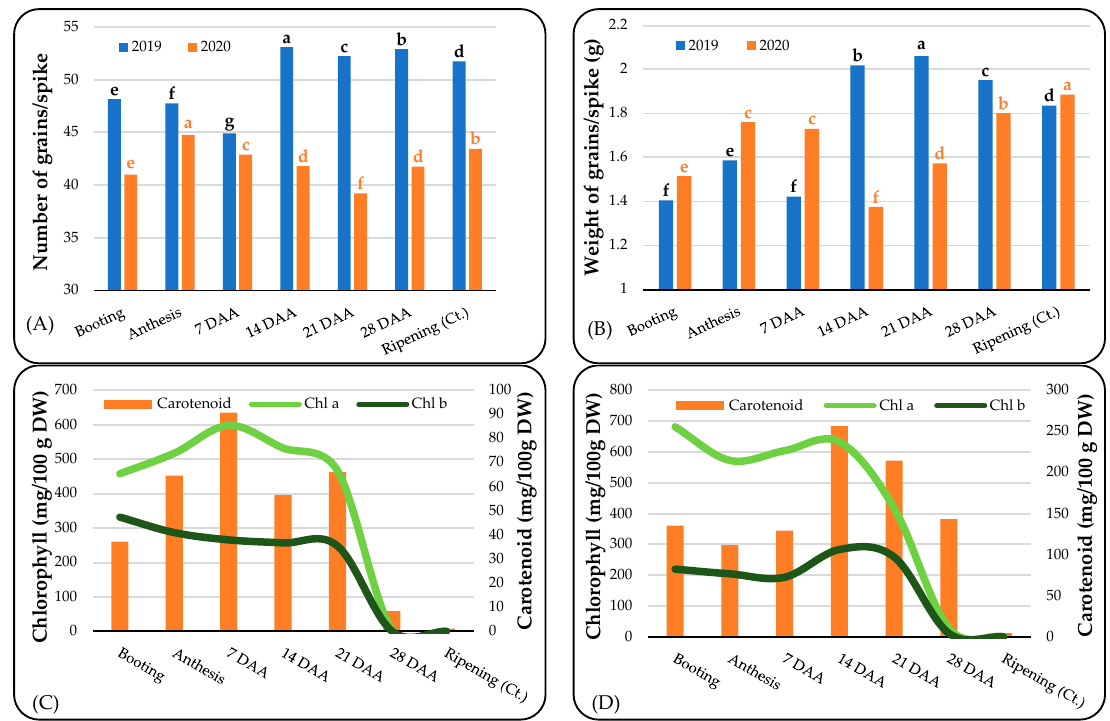
Figure 4. The variation of morpho- biochemical traits of Codru variety to different time removal flag leaf ( A , B ) number of grains/spike, respectively weight of grains/spike; ( C , D ) photosynthetic pigments-2019, respectively 2020. Different letters in ( A ) and ( B ) figures, the significance is represented according to Duncan Test.